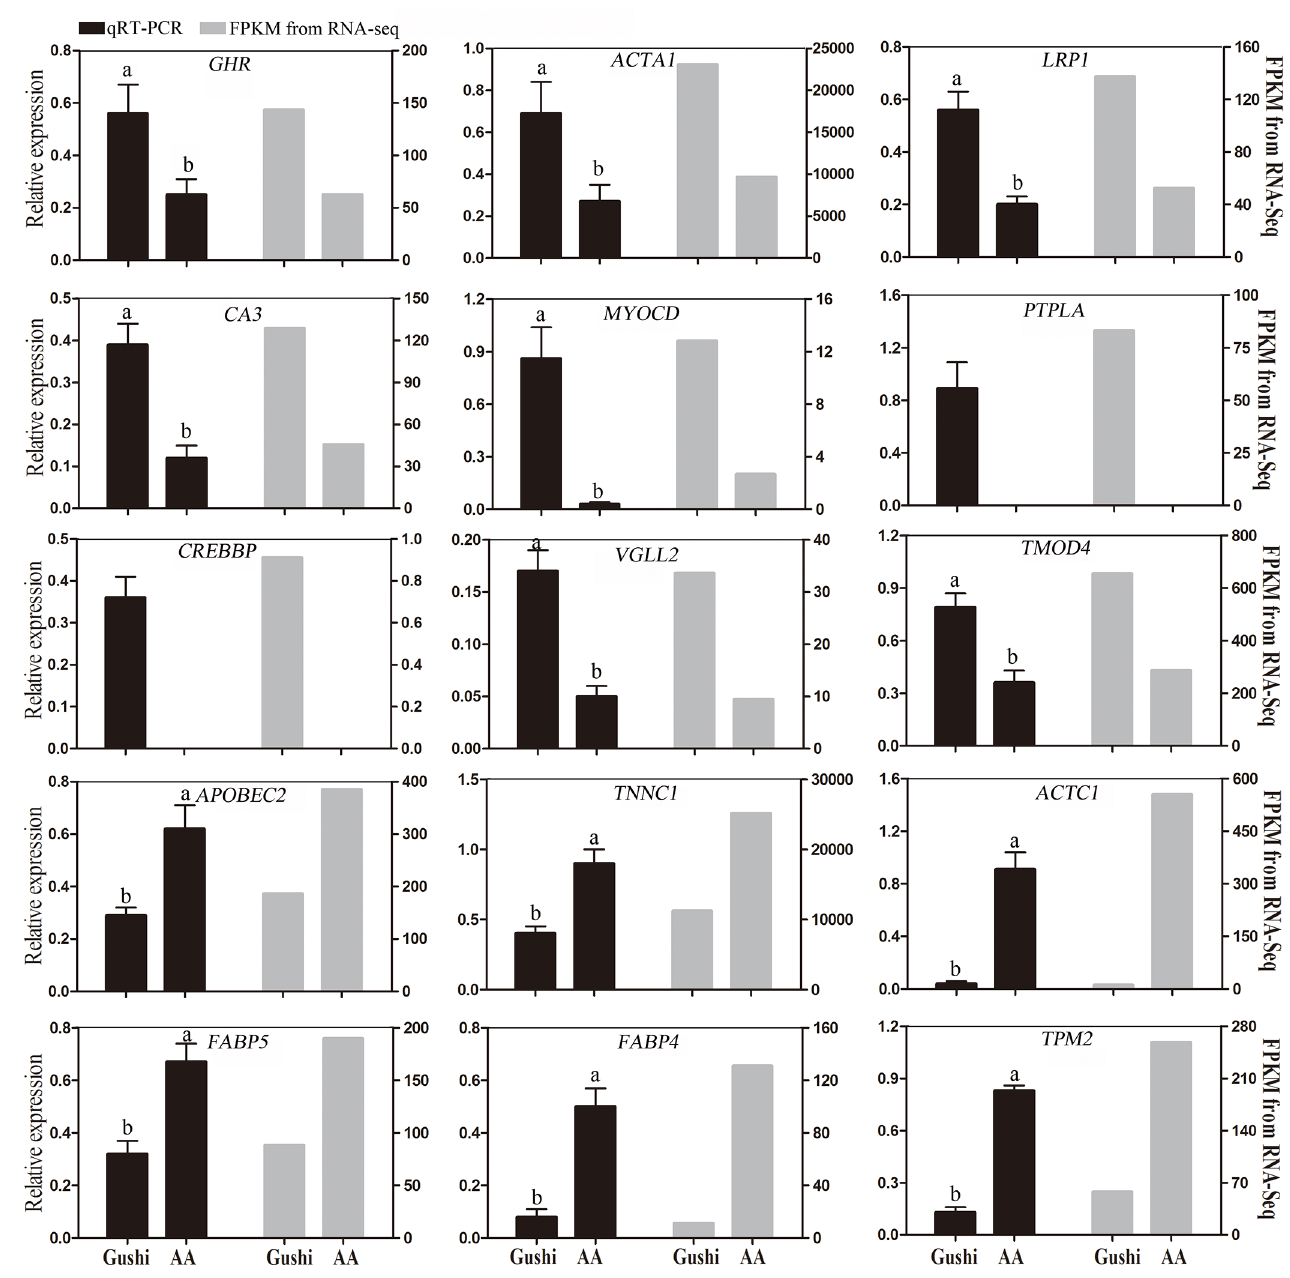
Fig 8. Validation of RNA-Seq data by qRT-PCR. Data were analyzedby the 2 – ΔΔ Ct method using GAPDH as a reference gene. The results are presented as fold changesin expression. Each column represents the means ± SEM from 3 biological replicates with each measurement repeated 3 times. Different lowercaseletters indicate significantdifferences in expressionlevels betweenthe two breeds (P (cid:20) 0.05). Black bars = qRT-PCR; Gray bars = FPKM from RNA-Seq.